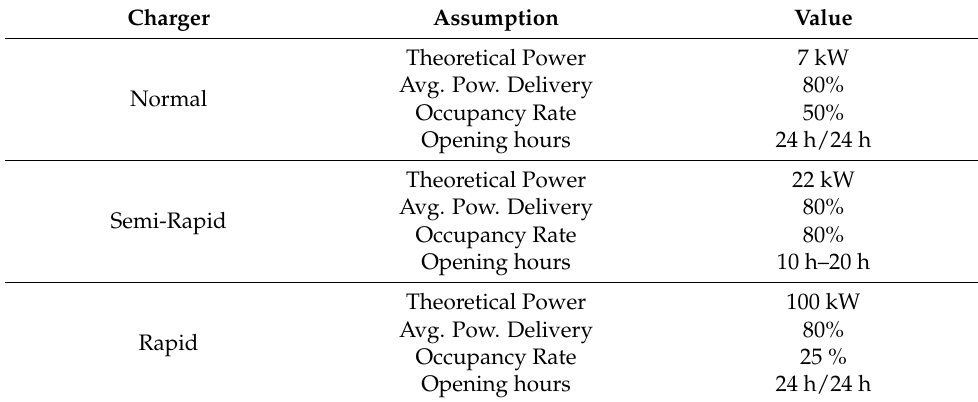
Table 5. Assumptions taken to convert the demand in kWh into a number of stations [34].